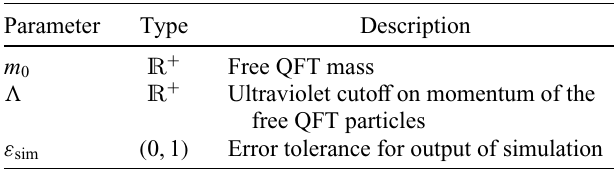
TABLE I. Inputs from client to the main